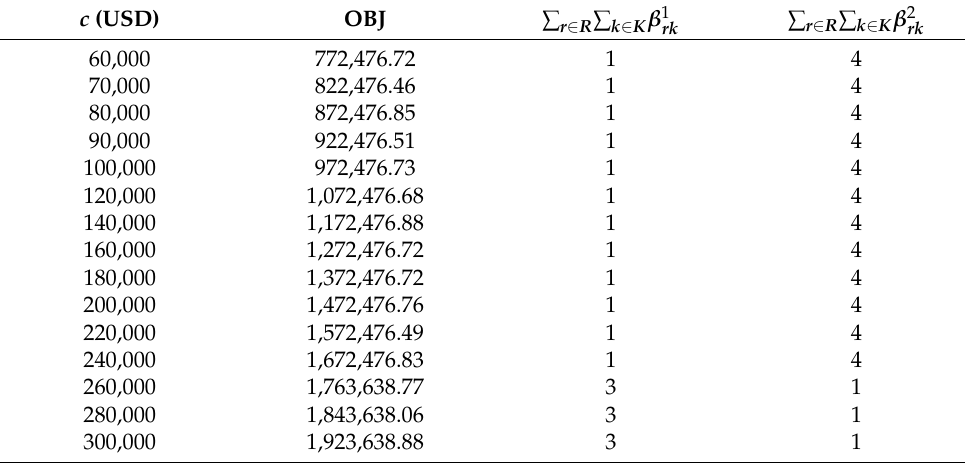
Table 6. Impact of weekly fixed operating cost on the operation decisions. c (USD) OBJ ∑ r ∈ R ∑ k ∈ K β 1